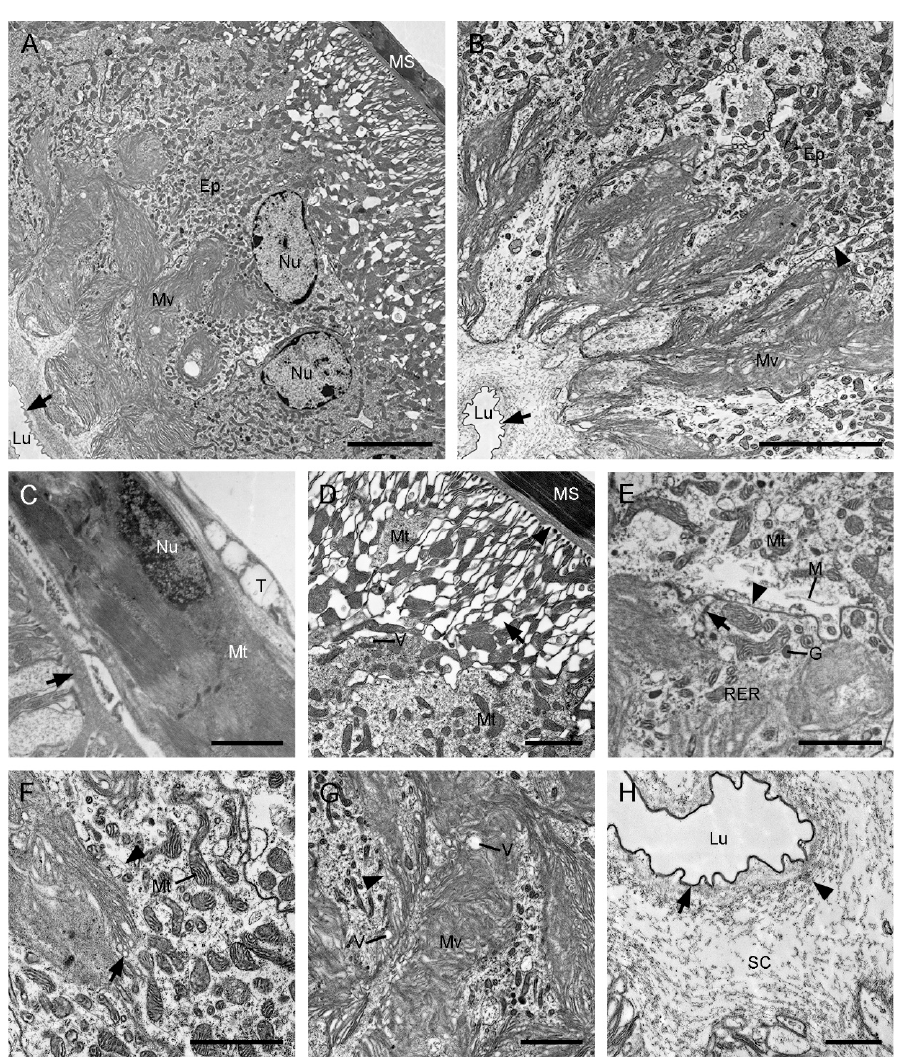
Figure 5. Median duct of the ejaculatory duct of Furcatopanorpa longihypovalva , cross-sections, TEM. ( A ) Muscular layers and epithelium. Arrow points to the inner cuticle. ( B ) Microvilli extend from the middle of the epithelium to near the central lumen. Arrowhead points to the plasma membrane. Arrow points to the inner cuticle. ( C ) Organelles and nucleus in muscle sheath. Arrow points to the basal lamina. ( D ) Basal part of the epithelium, showing mitochondrion. Arrow shows an intracellular space. Arrowhead points to the basal lamina. ( E ) Zonula adherens (arrow) and septate junction (arrowhead) in the apical region. ( F ) Organelles near by the base of the microvilli. Arrow points to the small vesicle. Arrowhead shows the microtubule. ( G ) Granules and vesicles around the microvilli. Arrowhead shows the microtubule. ( H ) Secretions in subcuticular cavity. Arrow shows the electron-dense granule. Arrowhead points to the inner cuticle. Ep, epithelium; Lu, lumen; M, microtubule; MS, muscular sheath; Mt, mitochondrion; Mv, microvillus; Nu, nucleus; RER, rough endoplasmic reticulum; SC, subcuticular cavity; T, tracheole; V, vesicle. Scale bars: ( A , B ) = 5 µ m; ( C – G ) = 2 µ m; ( H ) = 1 µ